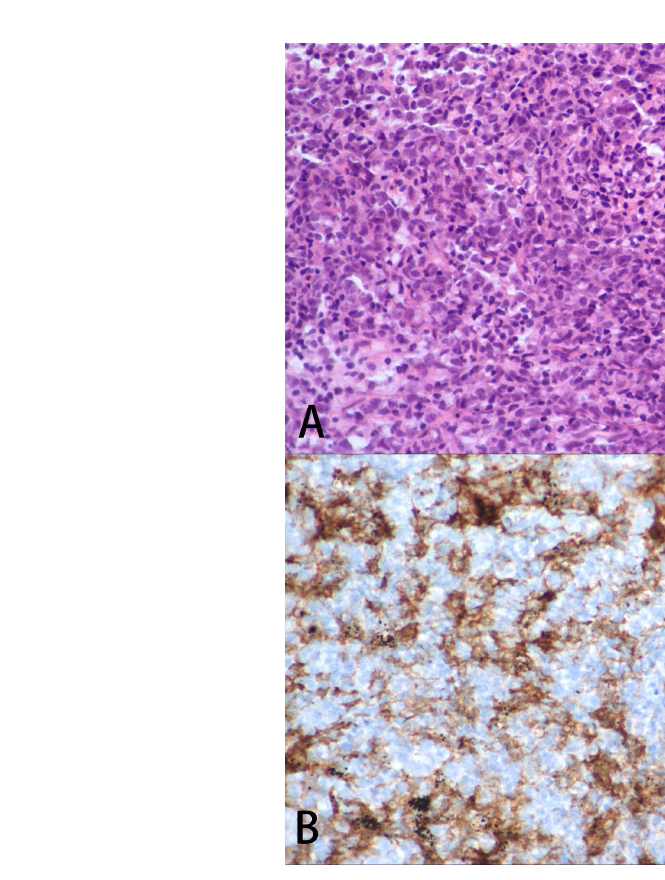
FIGURE 2 | Pathological analysis. (A) Pulmonary histopathology at disease progression, which was consistent with diffused large B cell lymphoma, ×200 H&E. (B) The lymphoma cells were PD-L1 positive,